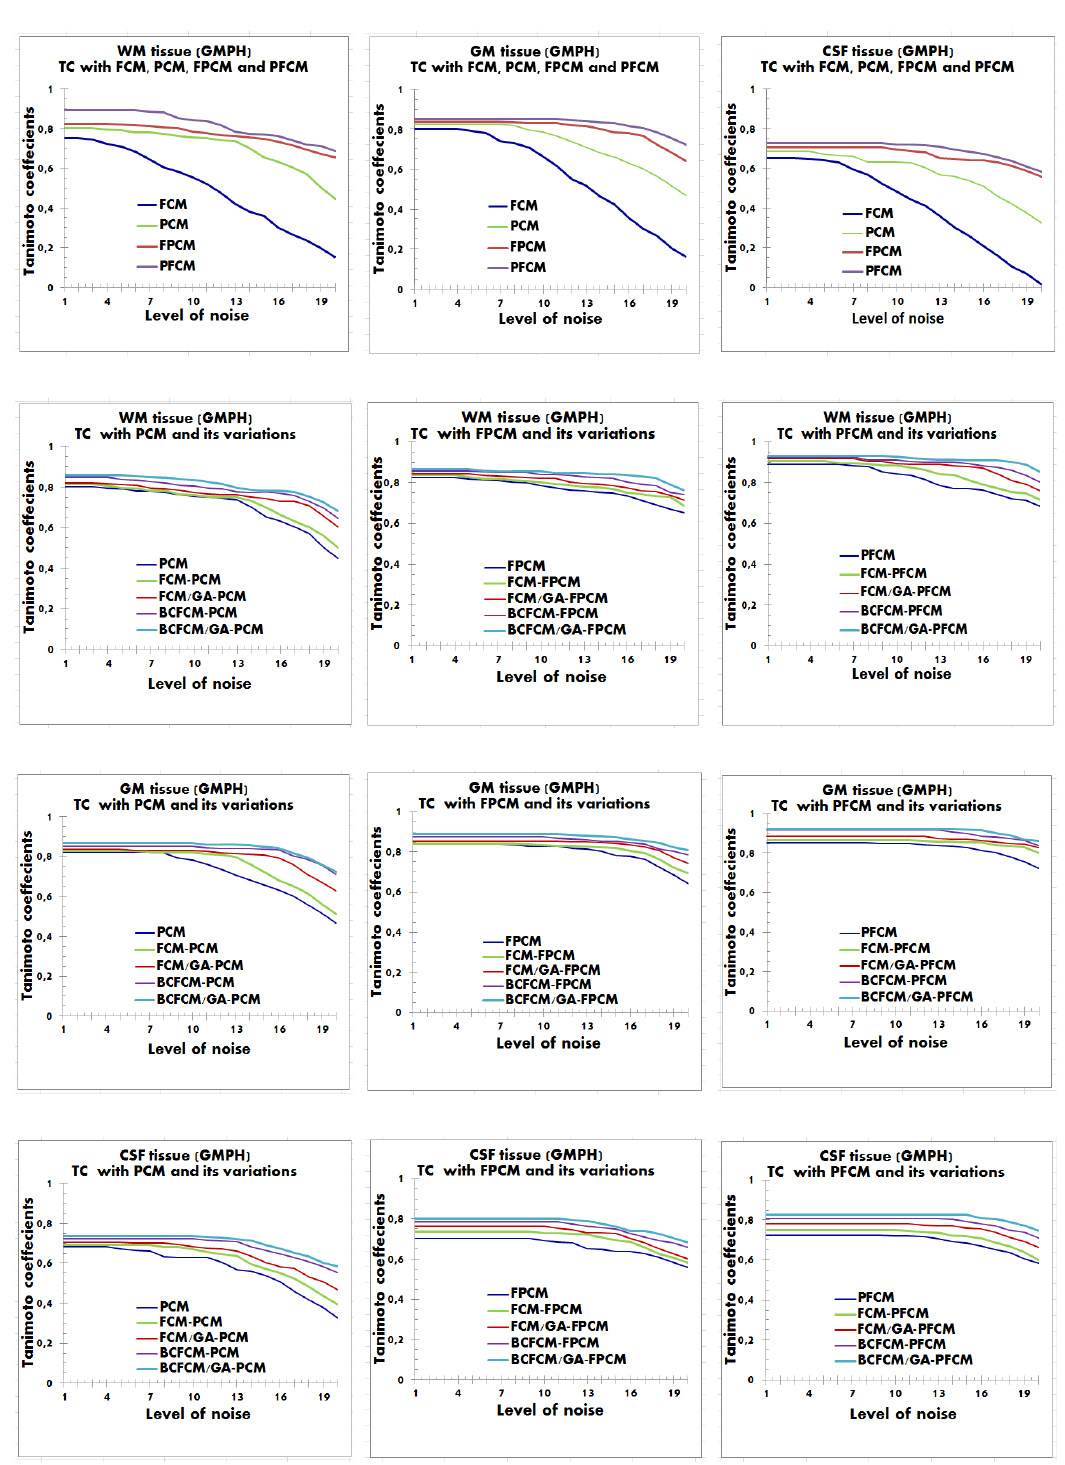
Figure 10. Curve of Tanimoto coefficients clustering index for WM, GM and CSF tissues with additive noise between 1% and 20%. Application with the hybrid approach BCFCM / GA / PFCM for a GMPH image. The results of modeling approaches from (1) to (15) are reported. viz., (1) FCM, (2) PCM, (3) FCM / PCM, (4) FCM / GA / PCM, (5) BCFCM / PCM, (6) BCFCM / GA / PCM, (7) FPCM, (8) FCM / FPCM, (9) FCM / GA / FPCM, (10) BCFCM / FPCM, (11) BCFCM / GA / FPCM, (12) PFCM, (13) FCM / PFCM, (14) FCM / GA / PFCM, (15) BCFCM / PFCM. Legend. BCFCM: Bias corrected FCM; FCM: Fuzzy